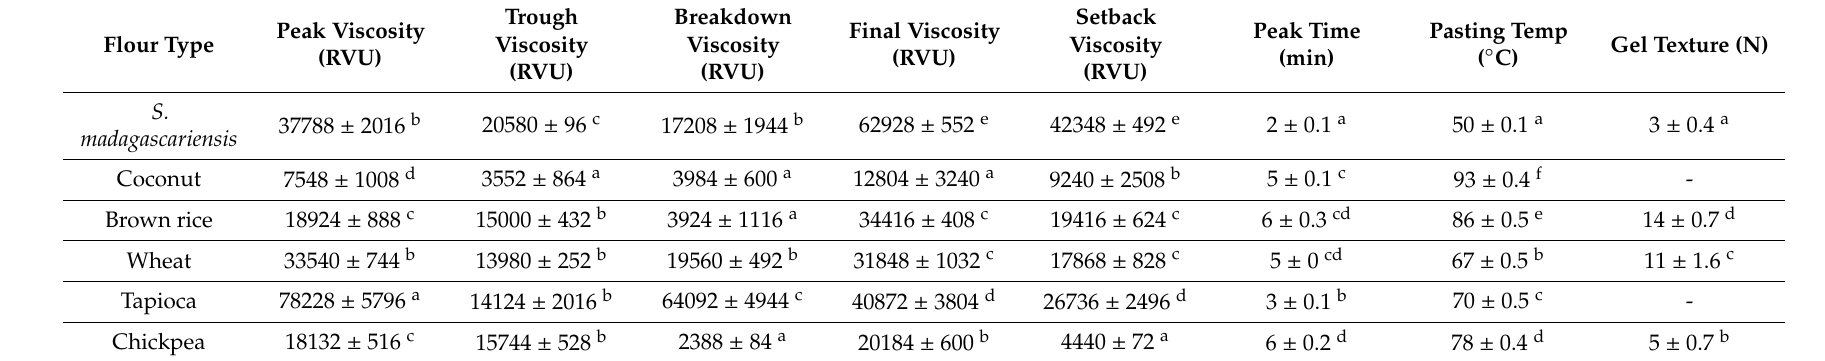
Table 3. Pasting properties of the Strychnos madagascariensis seed flour compared to the five reference flours.